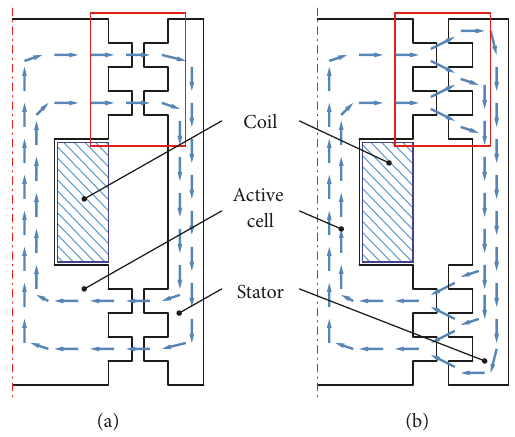
Figure 1: Axisymmetric schemes of (a) the traditional tooth structure and (b) the asymmetric tooth